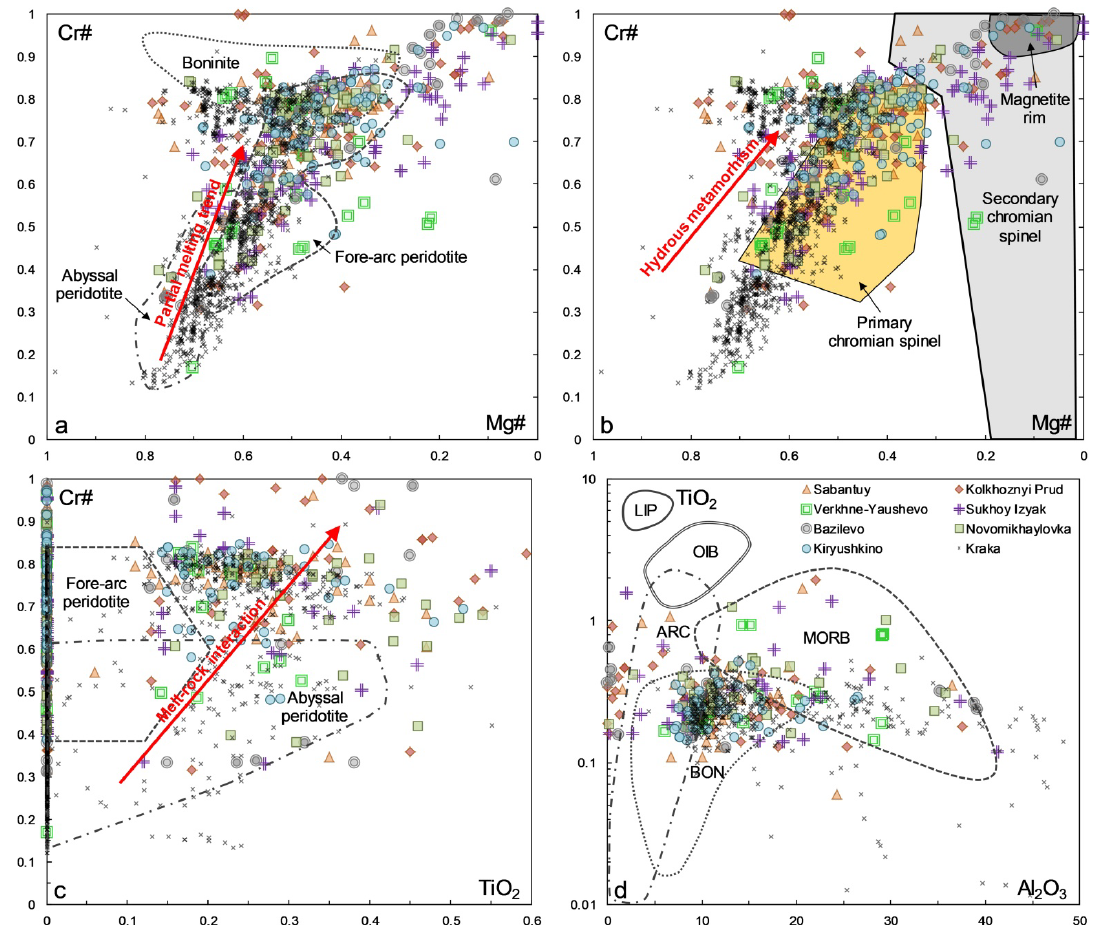
Figure 15. Discrimination diagrams for chromian spinels from the studied paleoplacers and Kraka ophiolitic massif (peridotites, dunites and chromitites): ( a )—Mg#–Cr# (mol.%) with fields, after [89,90], ( b )—Mg#–Cr# (mol.%) with fields, after [91], ( c )—TiO 2 –Cr# (wt.%–mol.%) with fields, after [89], ( d )—Al 2 O 3 –TiO 2 with fields, after [92]. ARC = arc volcanites, BON = boninites, LIP = large igneous province, MORB = mid-ocean ridge basalts, OIB = ocean island basalts.